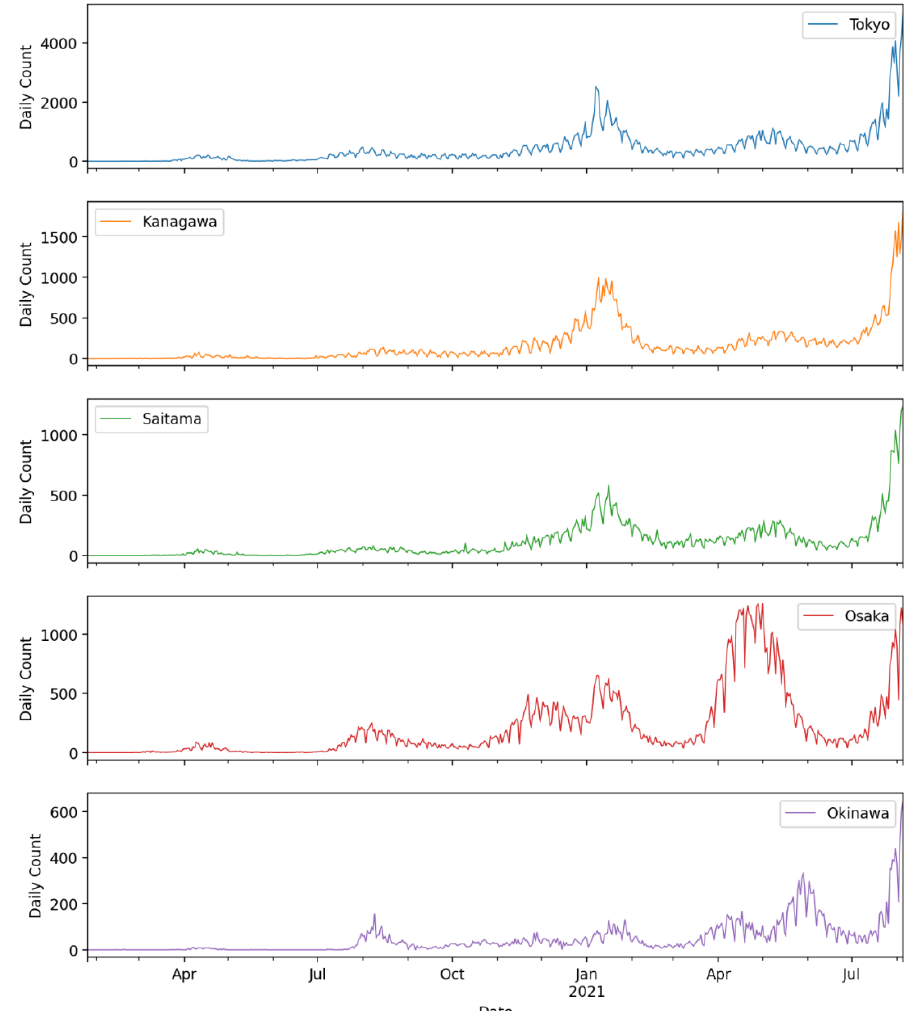
Figure 4. Bottom five prefectures with the lowest K-median values.